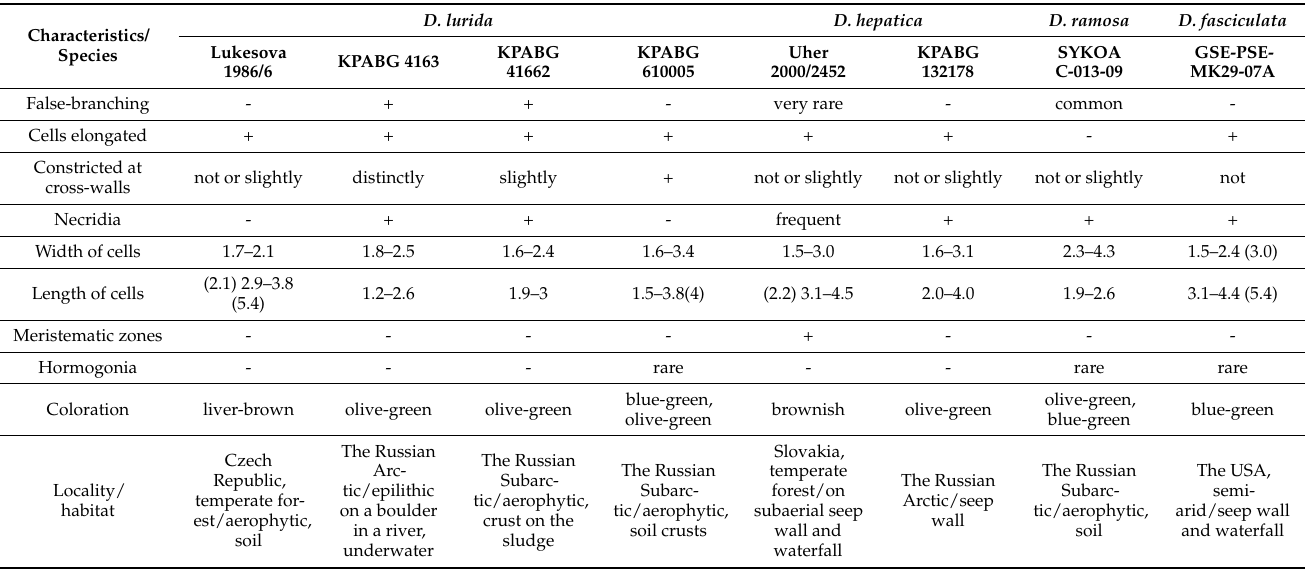
Table 2. Morphological comparison among the named Drouetiella strains. Information for the type strains were obtained from [22].